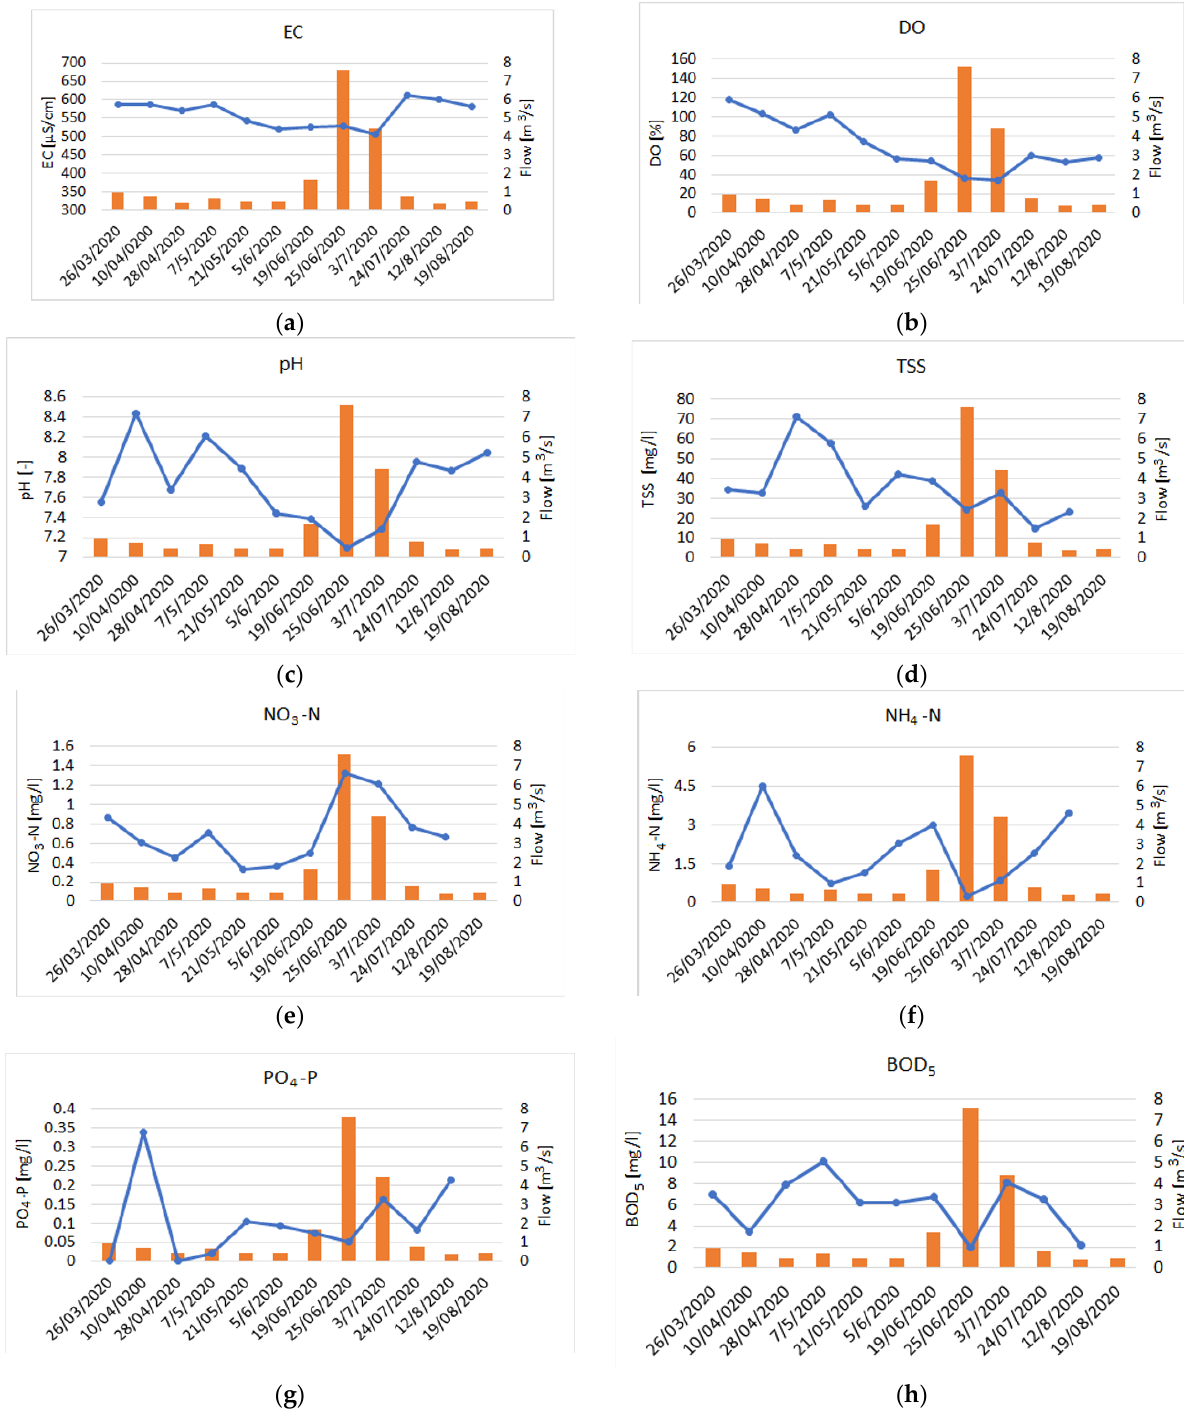
Figure 7. Variations in water quality parameters ( a ) EC ( b ) DO ( c ) pH ( d ) TSS ( e ) NO 3 -N ( f ) NH 4 -N ( g ) PO 4 -P ( h ) BOD 5 at site M8 from March to August 2020. Orange bars represent measured or calculated flow values.